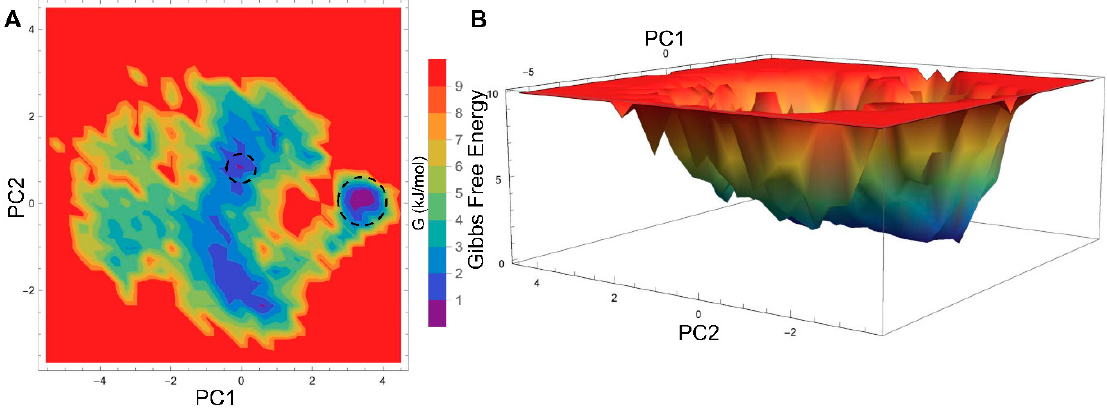
Figure 4. 2D free energy landscape (FEL) of PPAR- α apo form ( A and B ) displayed as a function of two principal components (PC1 and PC2), whose cosine content was less than 0.2. The minimal energy clusters are highlighted using black dotted circles.